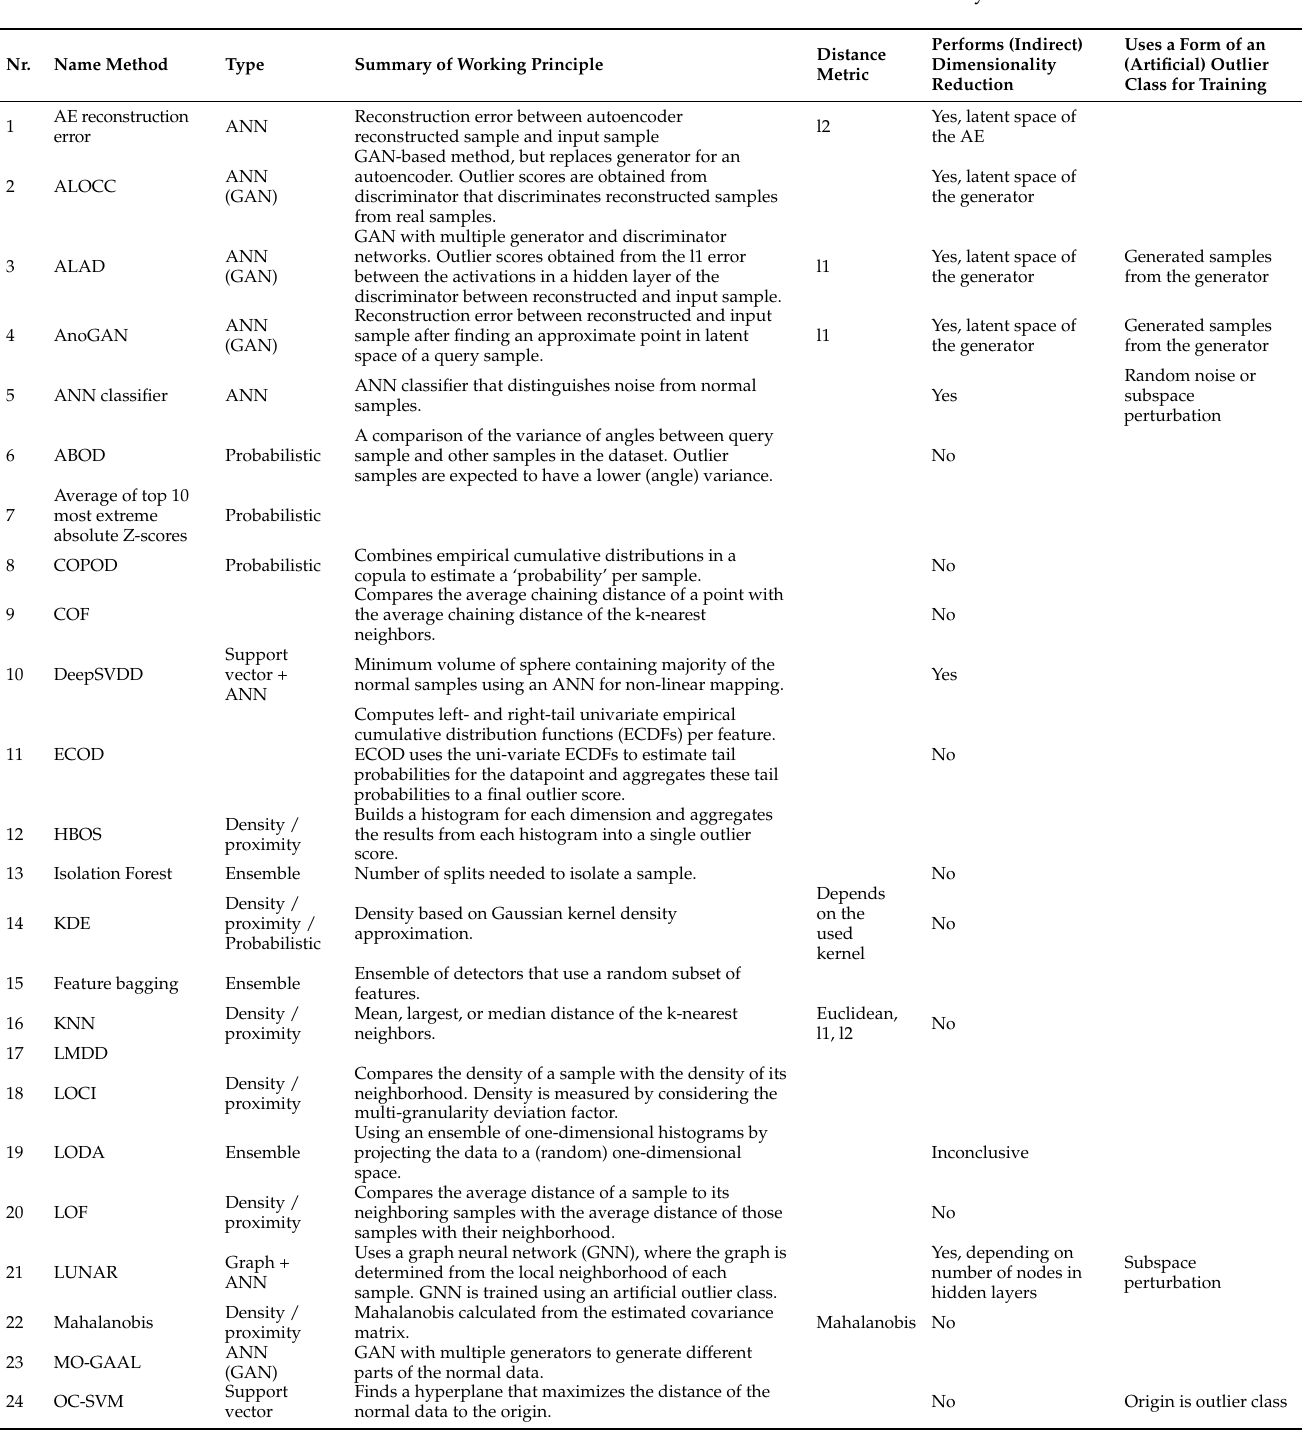
Table A1. Overview of outlier detection methods used in this